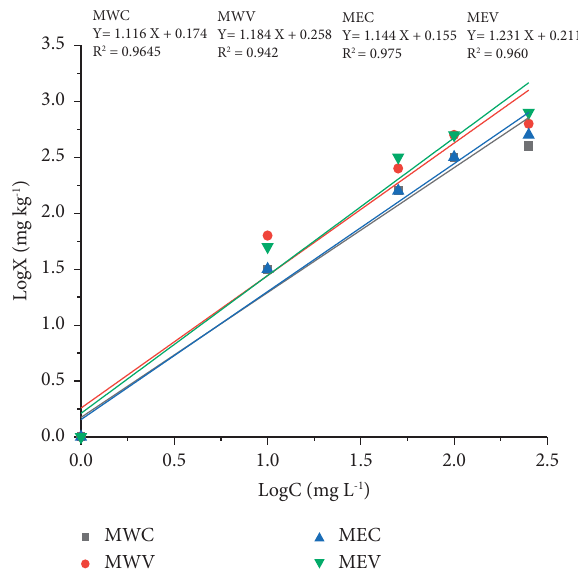
Figure 2: Linear Freundlich isotherm for the soil of Meupi (24hours equilibration at 25 ° (between 1.12 and 2.00 cmolc/kg), K + (between 0.51 and 1.96 cmolc/kg), and Na + (between 0.52 and 0.71 cmolc/kg). These